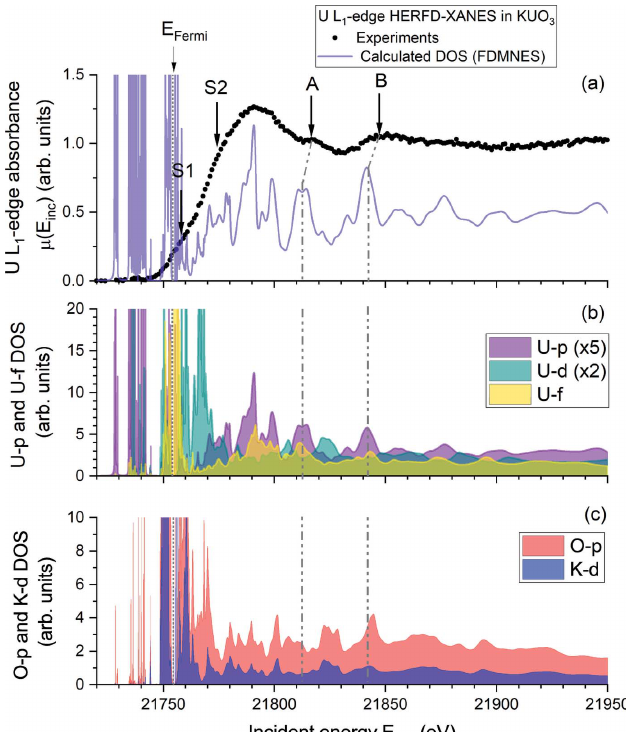
Figure 2 ( a ) Uranium L 1 -edge HERFD-XANES and the corresponding simulated spectrum using FDMNES . ( b , c ) Calculated U- p , U- f , O- p and K- d partial density of states, to allow direct comparison with the experimental XANES spectrum. The Fermi energy level is indicated with a vertical dotted line. Vertical dashed-dotted lines indicating the position of features A and B in partial DOS are also present to guide the eyes. The intensity of U- p and U- d partial DOS in subplot ( b ) were here multiplied by 5 and 2, respectively, to better distinguish each contribution. We refer to Figure 6 of the supporting information for the other calculated partial